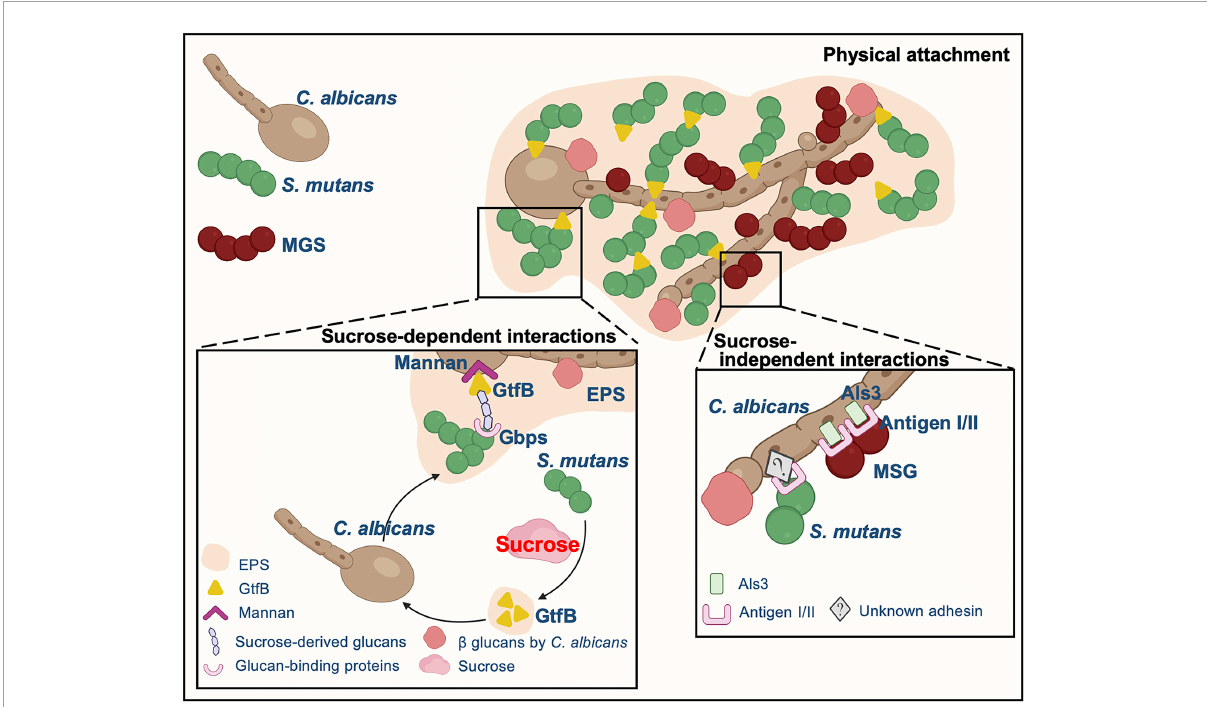
FIGURE2 The typical physical attachment mechanisms underlying the interaction between C. albicans and streptococci. C . albicans physically interacts with MGS through proteins/receptors on cell wall surface of both fungi and bacteria whereas EPS is critical to the mutualistic interaction between C. albicans and S. mutans instead of cell-cell physical